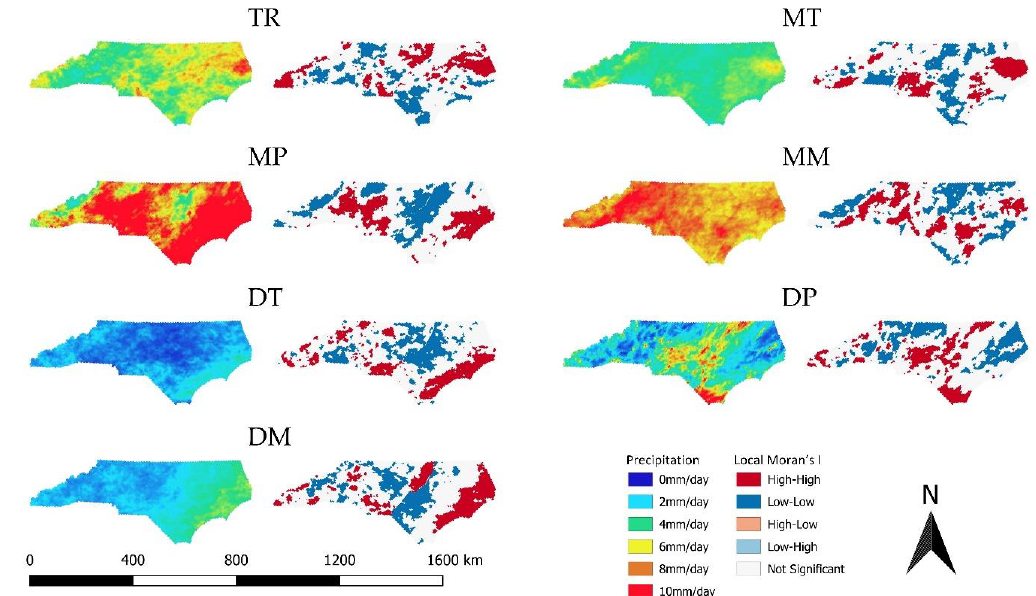
Figure 9. Same as Figure 5 but for summer (JJA). Summer (JJA) daily average precipitation ( left ) and spatial clustering analysis of precipitation ( right ) for each SSC air mass